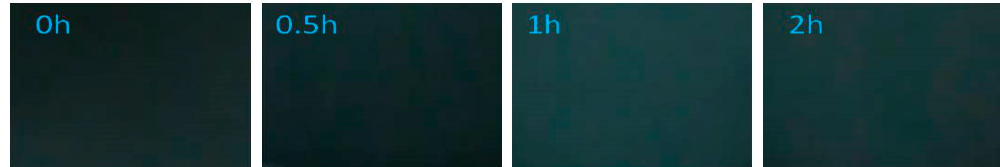
Figure 9. Variation of color for System 3, as a function of the UV irradiation time exposure.